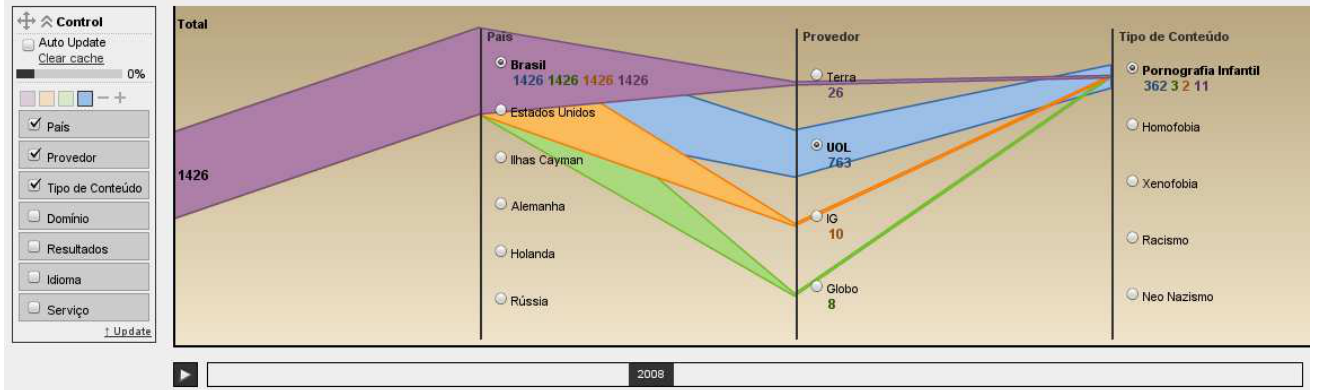
Fig. 9. Brazilian providers that hosted child pornography reported content in 2008